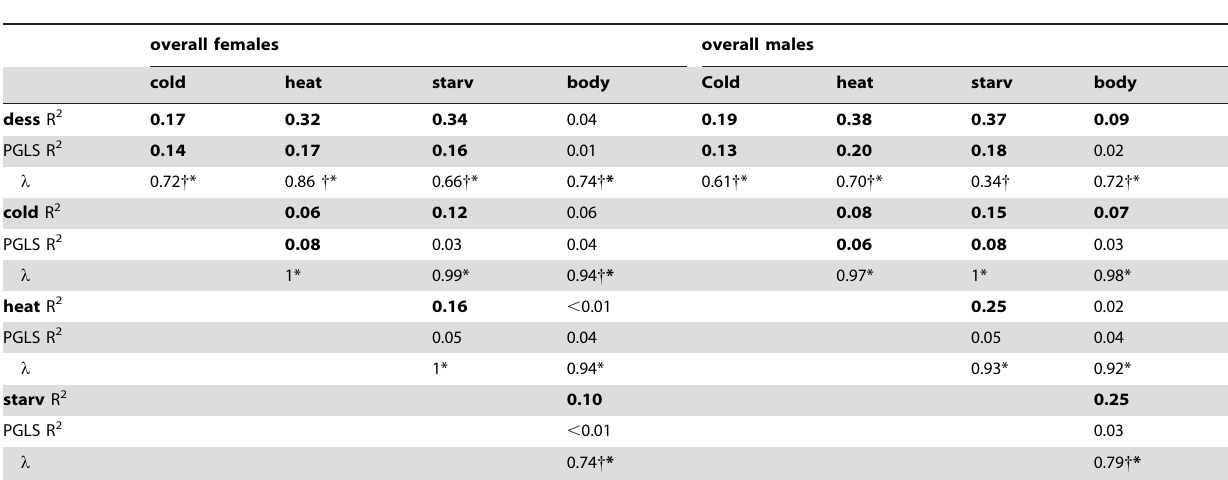
Table 1. Correlations for resistance to desiccation (dess), cold, heat and starvation (starv), and for body size (body) for female and male Drosophila